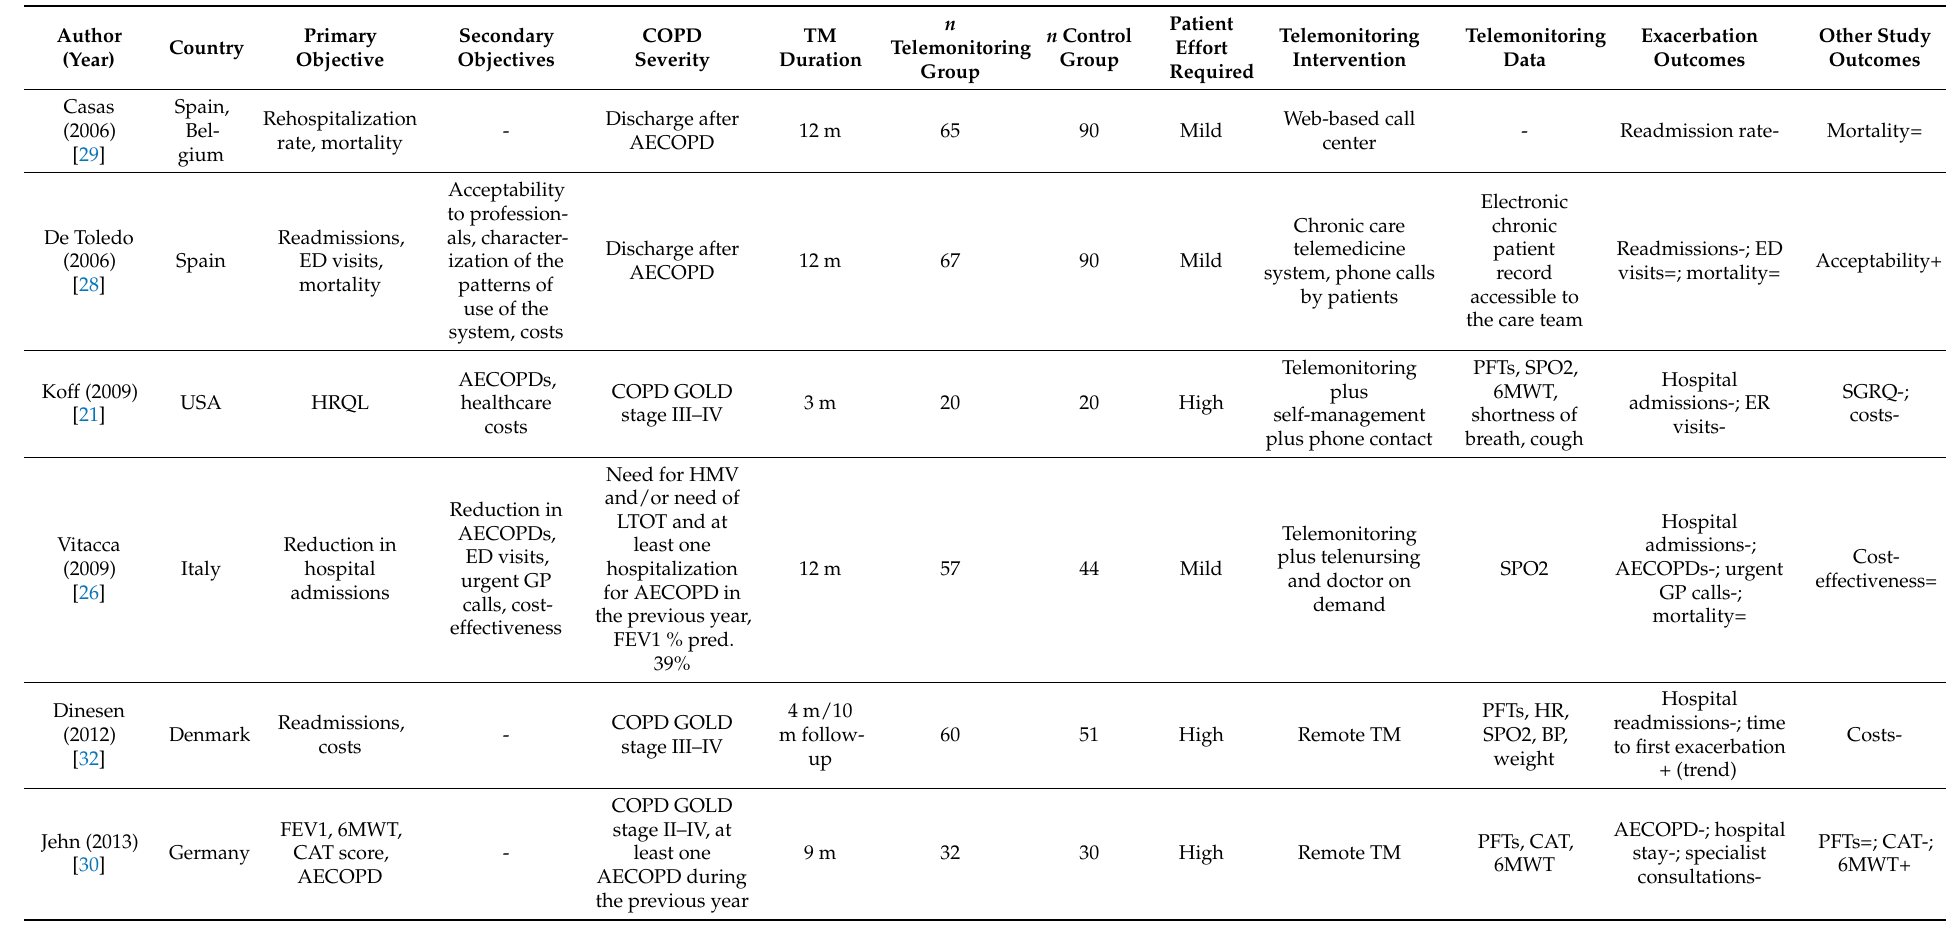
Table 1. Telemedicine studies showing positive